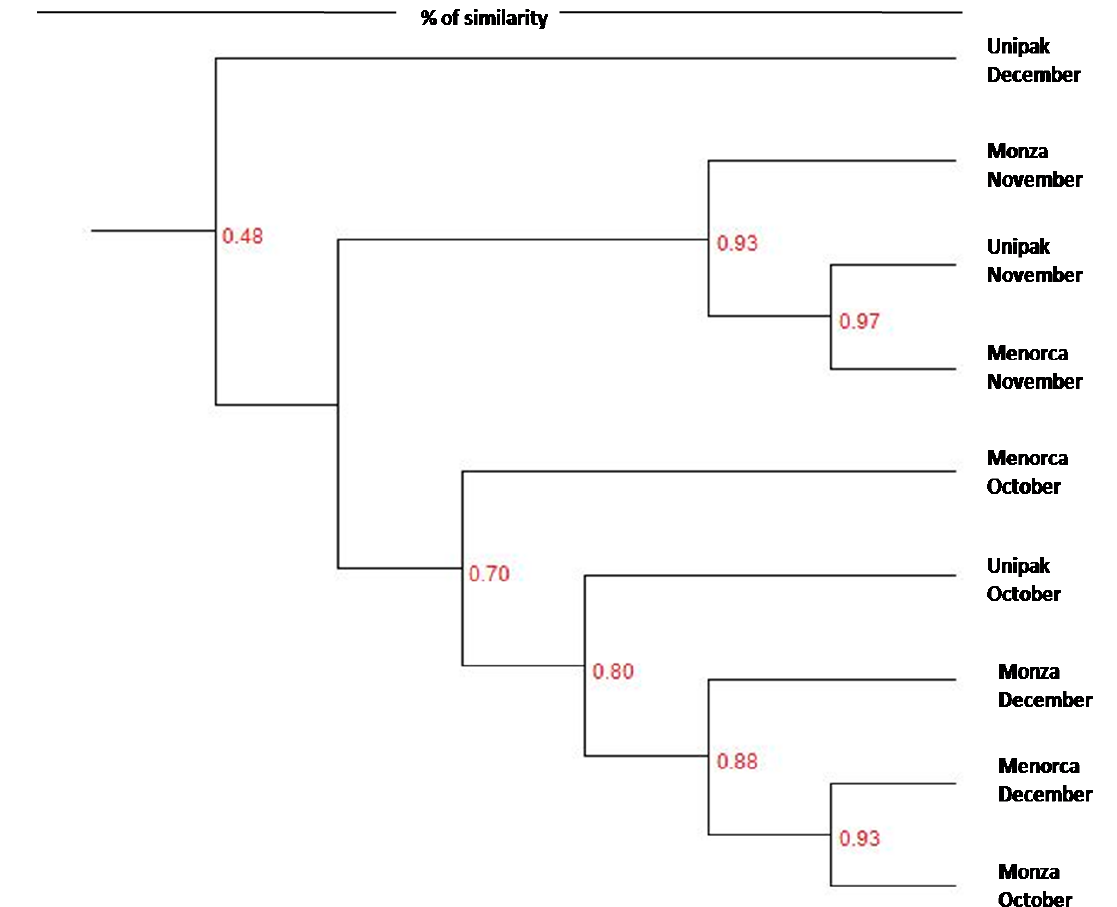
Figure 2. UPGMA dendrogram constructed based on the similarity between DGGE profiles for the three spinach cultivars and the three times of sampling. (Percentage of similarity is indicated at each